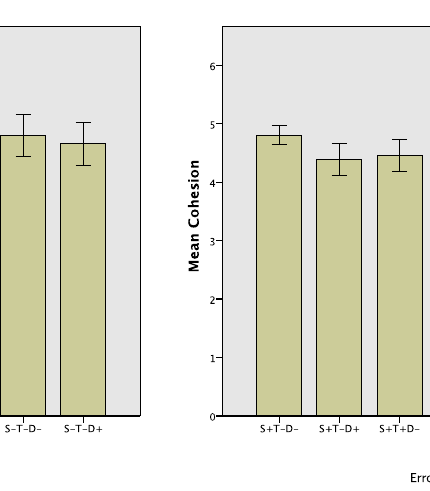
Figure 5: Average scores of expressivity for the different conditions of spatial synchronicity (S+/S-), temporal synchronicity (T+/T-), and inter-robot distance (D+/D-).